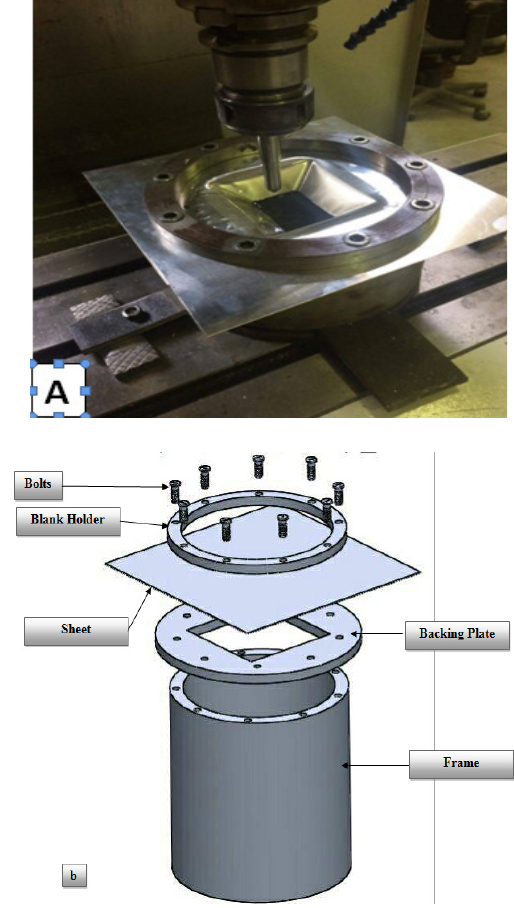
Fig. 7. SPIF equipment used in the study, a) physical tools representation, b) assembly view representation.